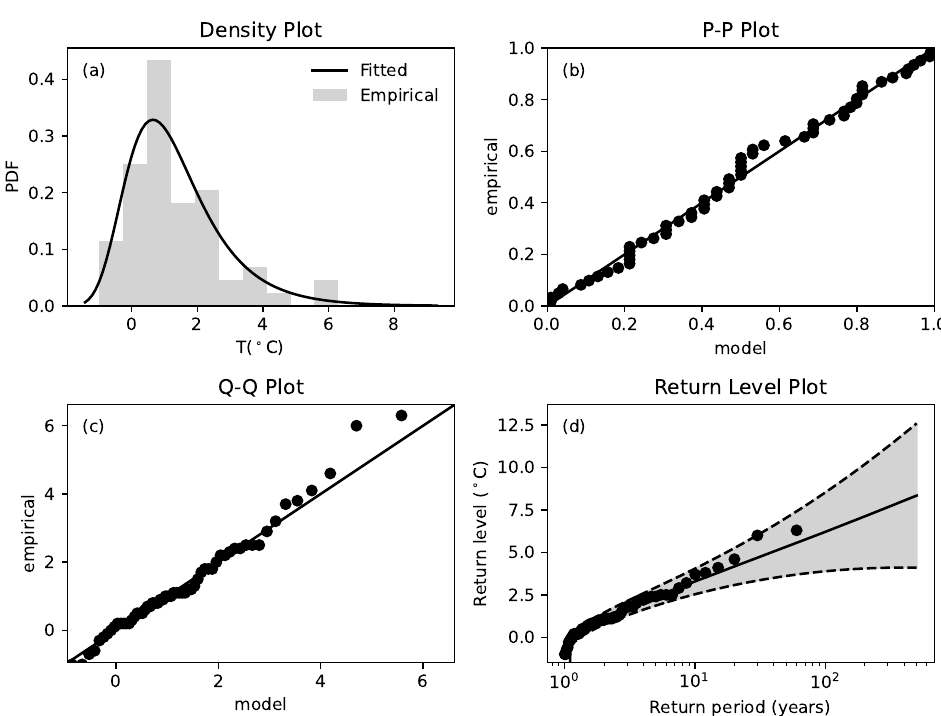
Figure 3. The four diagnostic plots for maximum temperatures at the Halley Met Station, as described in the text. ( a ) represents the density plot, the data are represented by histogram bars and the solid line corresponds to the fit with the Generalized Extreme Value (GEV) function. The probability plot and the quantile plot are reported in ( b , c ), respectively (the full line is the theoretical model). The return level plot is reported in ( d ). The grey area between the dashed lines represents the 95% confidence interval for the probability of